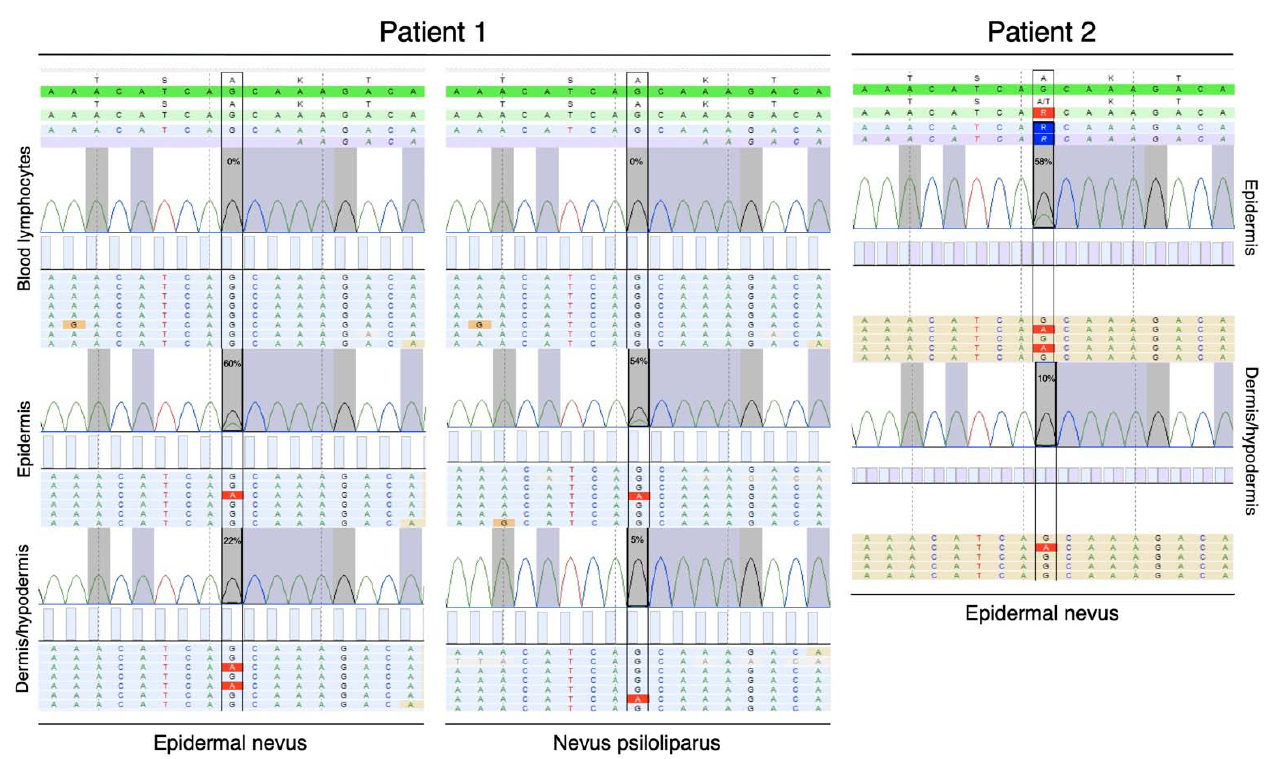
Figure 3. Molecular genetic testing. Left panel: Next-generation sequencing on DNA extracted from a skin biopsy in the epidermal nevus of patient 1 identified a mosaic missense variant (c.436G > A, (p.Ala146Thr)) in the KRAS gene with variant frequencies of 60% in cells of the epidermis and 22% in the dermis/hypodermis. DNA extracted from the nevus psiloliparus identifies the same KRAS variant with a frequency of 54% in the epidermis and 5% in the dermis/hypodermis. DNA from peripheral leukocytes does not contain the KRAS variant. Right panel: Identically, in patient 2, the p.(Ala146Thr) variant was identified in the DNA extracted from the epidermal nevus with a frequency of 58% and 10% in the epidermis and dermis/hypodermis, respectively (green color: reference sequence, blue and brown color: sample sequence, red: aberration from the reference sequence).